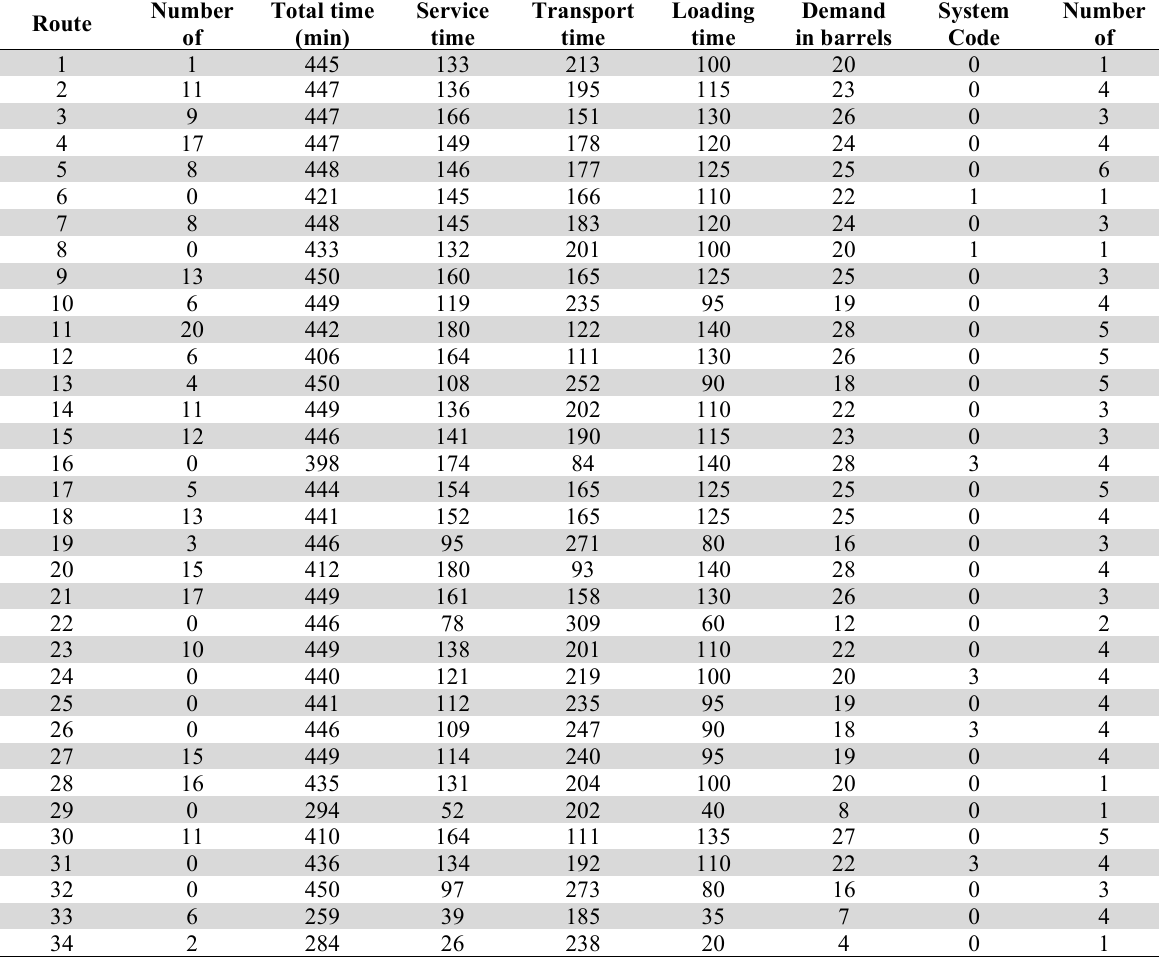
Description of routes in solution of Instance II: complete schedule